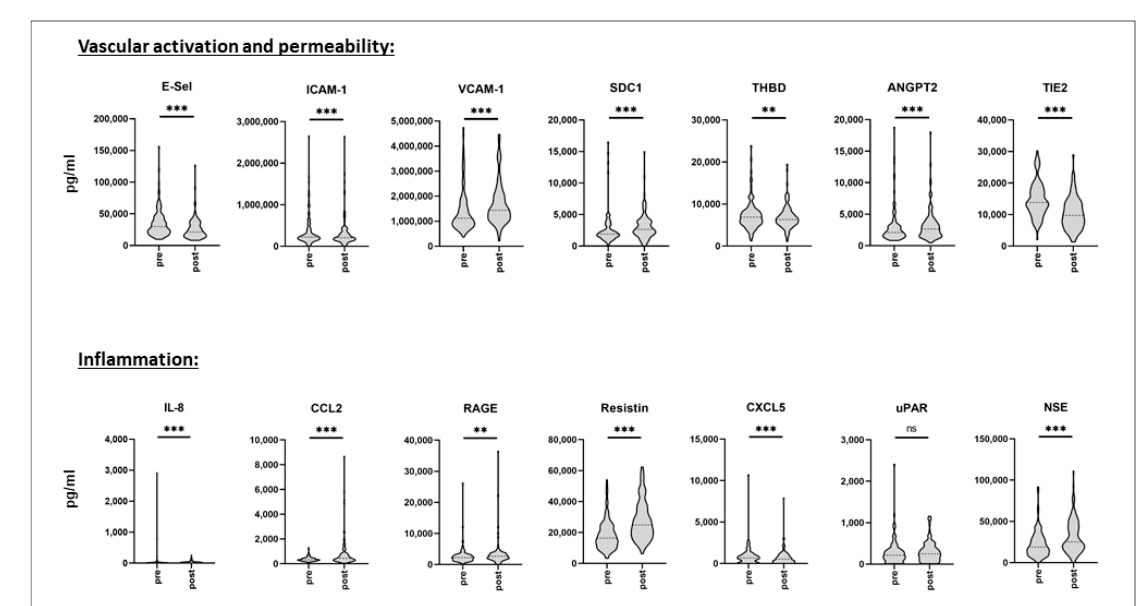
Figure 1. Pre- and postoperative serum biomarker profiling. Serum was sampled prior to and following surgery from a mixed cohort of consecutively recruited elective non-cardiac as well as cardiac surgery patients. Biomarker profiling was performed using the multiplex array technique. Data are given as median values (black dashed line) with 25th and 75th percentile (white dashed lines) and were compared using the Wilcoxon rank-sum test. n = 118. ns = not significant, ** p <0.01, *** p <0.005. E-Sel = E-Selectin, ICAM-1 = Intercellular Adhesion Molecule 1, VCAM-1 = Vascular Cell Adhesion Protein 1, SDC1 = Syndecan-1, THBD = Thrombomodulin, ANGPT2 = Angiopoietin-2, TIE2 = Tyrosine Kinase with Immunoglobulin-like and EGF-like domains 2, IL-8 = Interleukin-8, CCL2 = CC-chemokine Ligand 2, RAGE = Receptor for Advanced Glycation Endproducts, CXCL5 = C-X-C Motif Chemokine 5, uPAR = Urokinase Plasminogen Activator Surface Receptor, and NSE = Neuron.